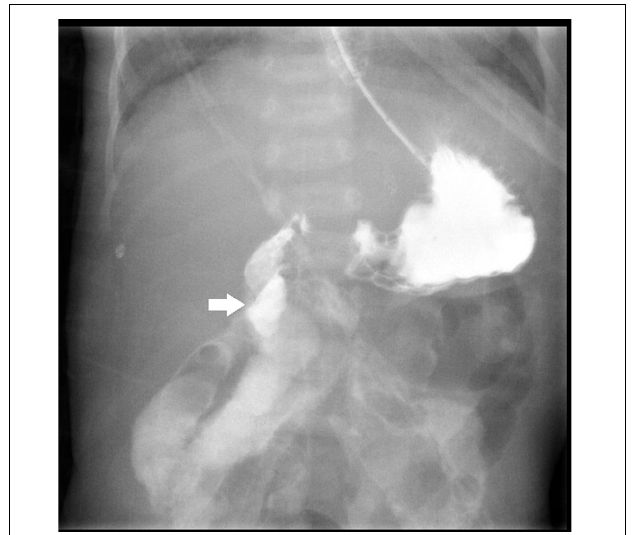
FIGURE 1 | Upper gastrointestinal series with water-soluble contrast shows right-sided duodenojejunal junction with suspicious Ladd band compression at the 2nd portion of the duodenum (white